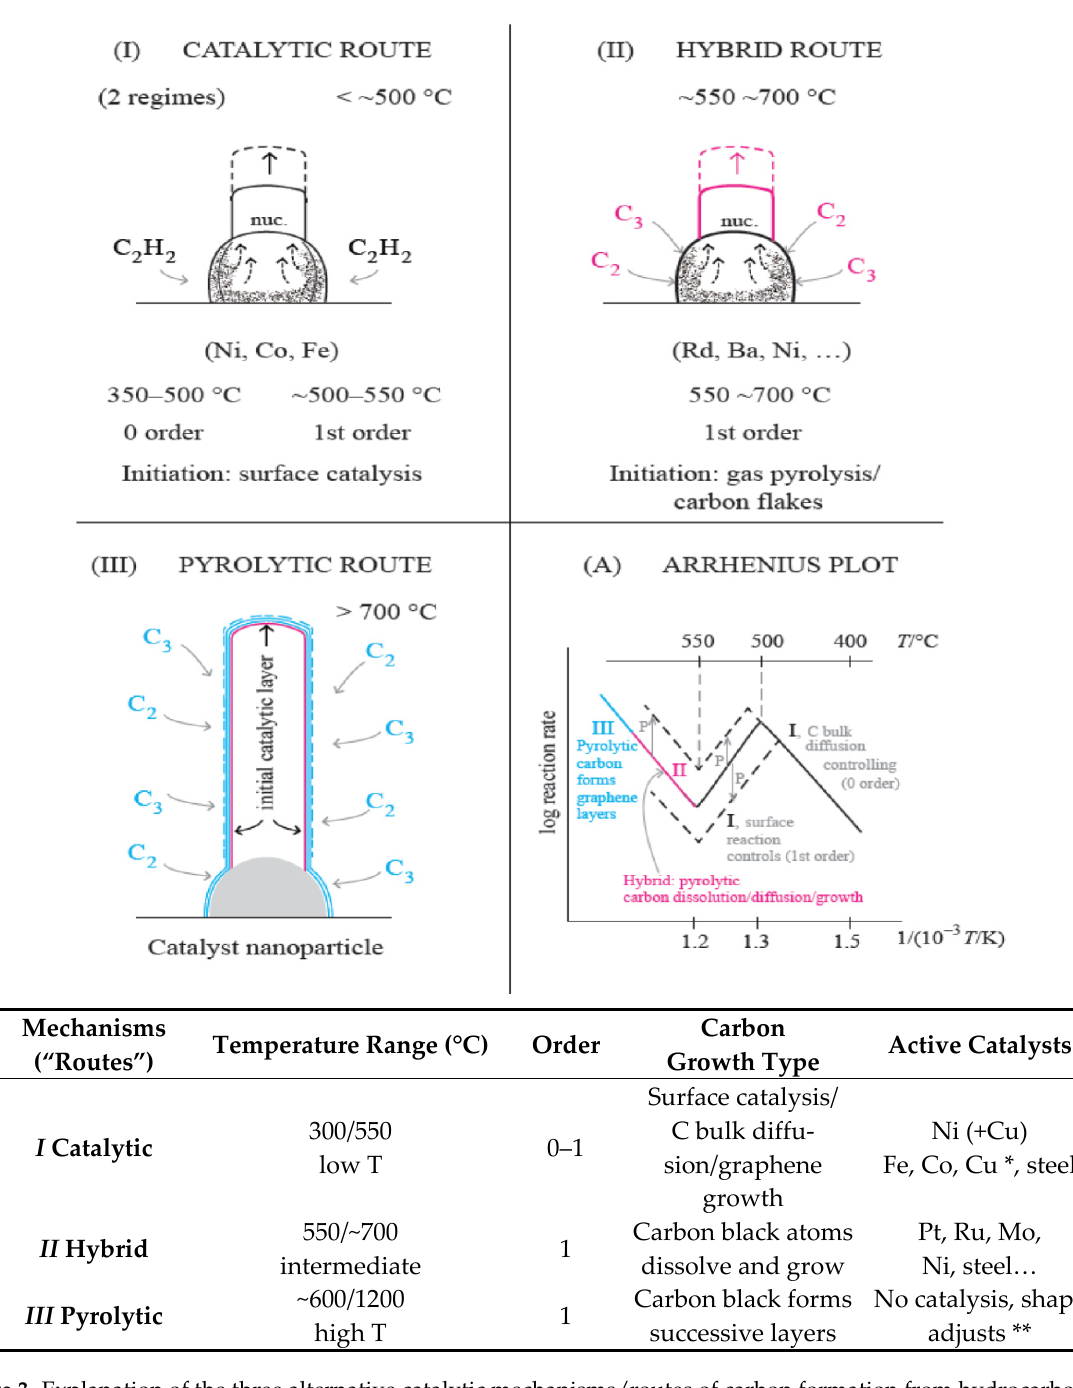
Figure 3. Explanation of the three alternative catalytic mechanisms/routes of carbon formation from hydrocarbons over different temperature/pressure ranges. When more than one mechanism may operate, the faster one prevails (adapted from [51] with permission from MDPI). * With Cu: at 250 °C. ** Graphene functionalization properties are extensively studied today.